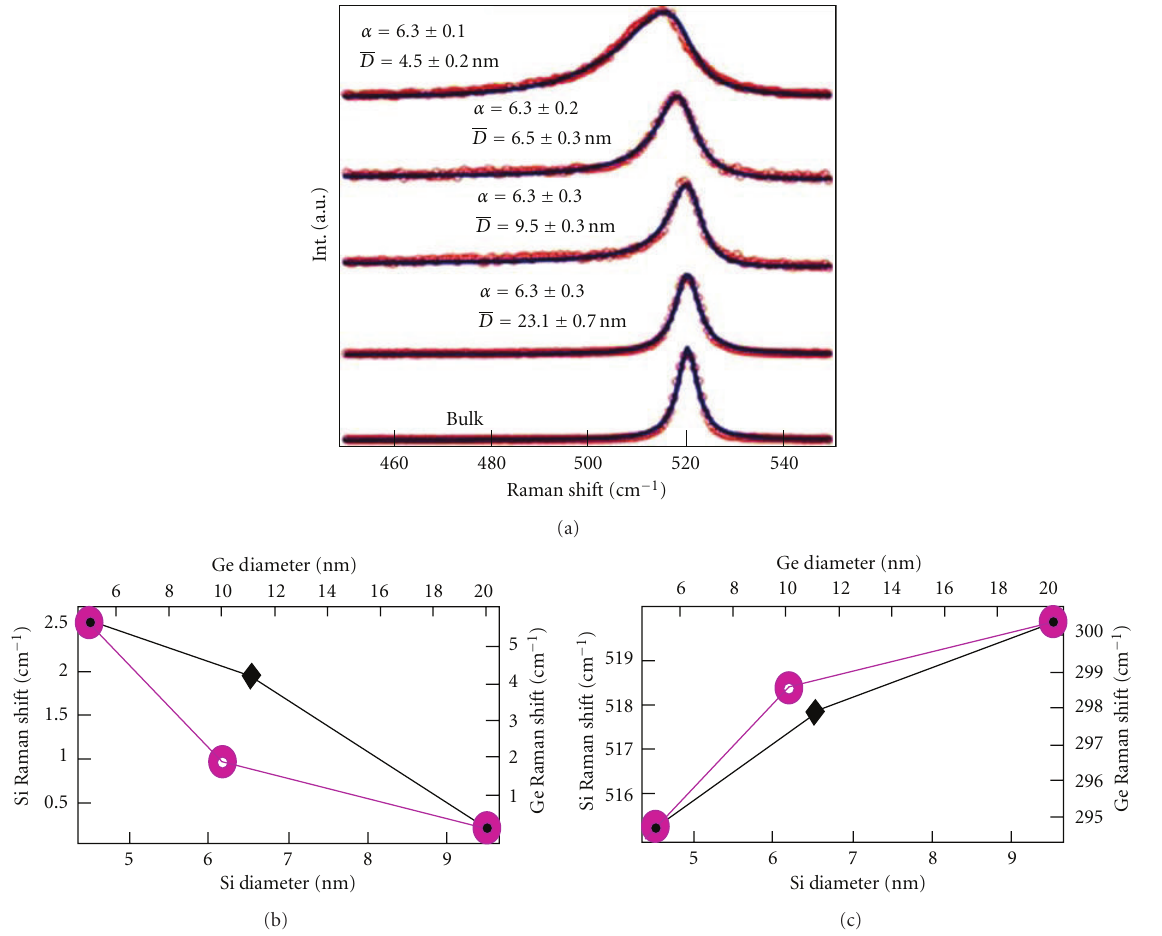
Figure 7: (a) Raman spectra showing the first-order Raman band peaks in four ensembles of Si nanowires. The bulk Si (001) spectrum is also shown. Experimental data: red open circles, least-square fit: black solid lines. α is the attenuation factor of the phonon (the width of the Gaussian phonon quantum confinement function) at the real boundary r = D/ 2, D is the most probable diameter. (b) Comparison of experimental Raman shift of TO phonon in Si [47] and Ge nanowires [80] for di ff erent diameters. Top: absolute shift Si (diamond), Ge (circles); bottom: nanowire Raman shift relative to bulk. Note that the Ge diameter range is twice that of Si.